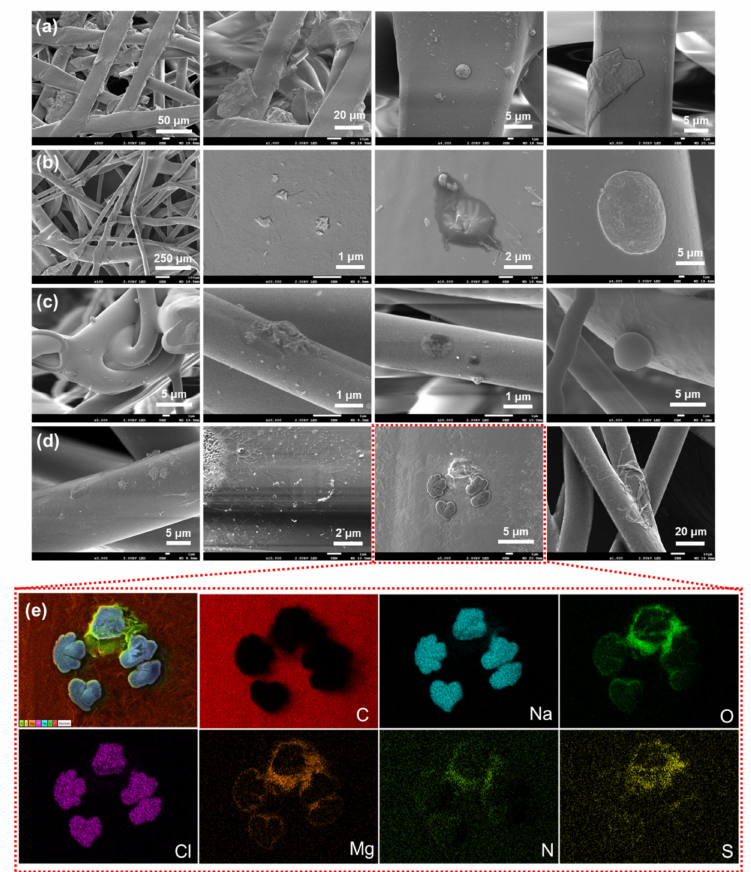
Figure 6. Scanning electron microscopy (SEM) images of a KF94 mask after it was subjected to actual use for a week. ( a ) Outer, ( b ) support, ( c ) filter, and ( d ) inner layers. ( e ) Energy-dispersive after